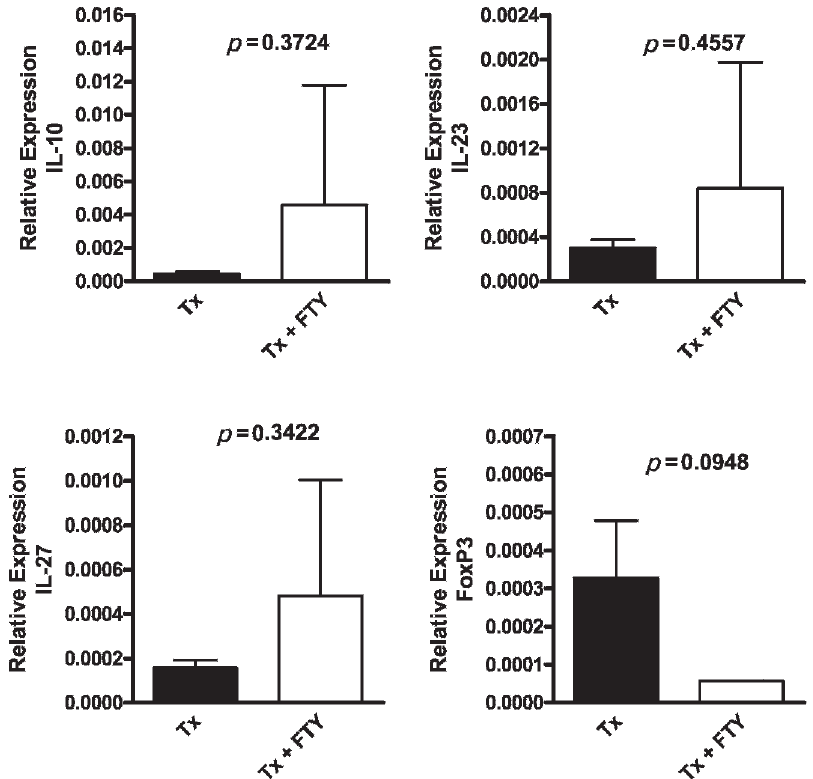
Figure 6 - FTY720-treated mice present an increase in the relative gene expression (qPCR analysis) of IL-10, IL-23, and IL-27 in the skin grafts. The relative gene expression (qPCR analysis) of FOXP3, IL-10, IL-23, and IL-27 in the F1 skin grafts was evaluated in the Tx non- treated and Tx + FTY720-treated mice. The results are expressed as the means